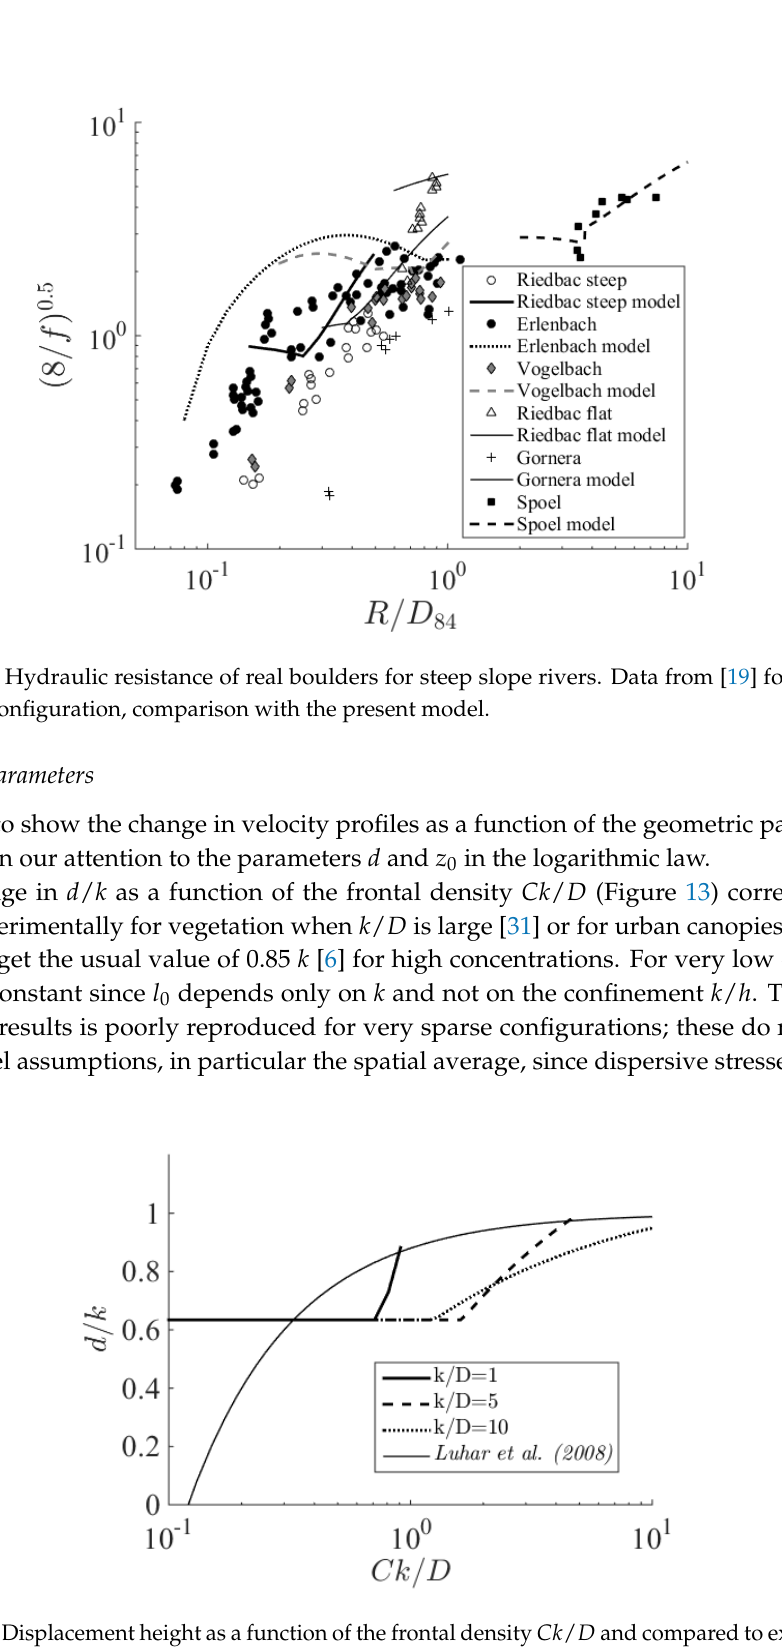
Figure 13. Displacement height as a function of the frontal density Ck / D and compared to experimental correlation from